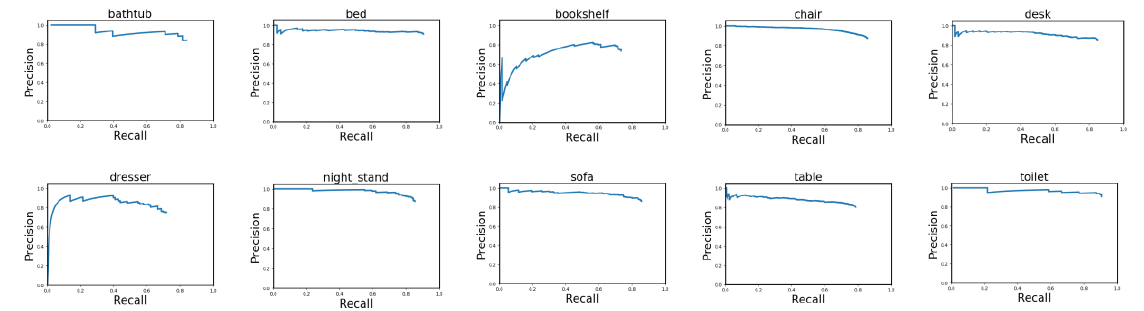
Figure 5. Precision recall (PR) curves for 3D object detection on SUN-RGBD val set.